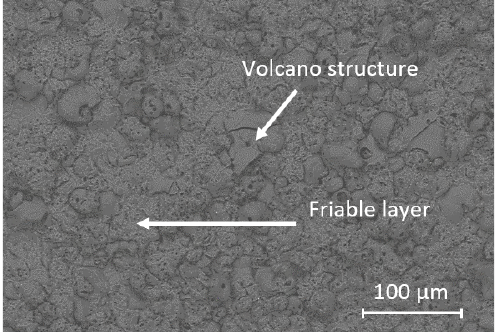
Figure 1. Volcano structure characteristic of a MAO